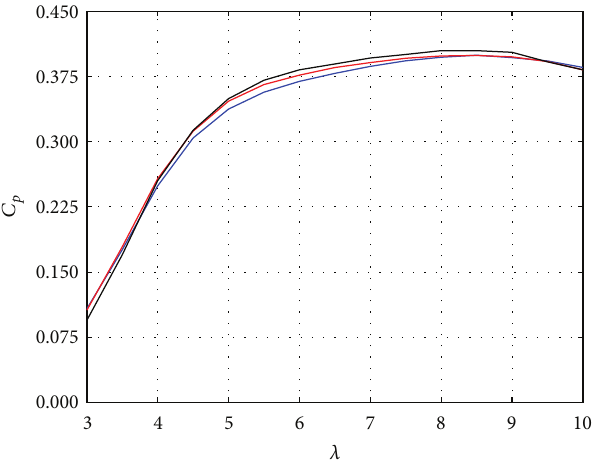
Figure 9: 𝐶 𝑝 versus 𝜆 for 𝑁 crit = 6 (blue), 8 (red), and 10 (black). Model input: 𝑈 ∞ = 11.1 m/s, Viterna, tip loss model on.